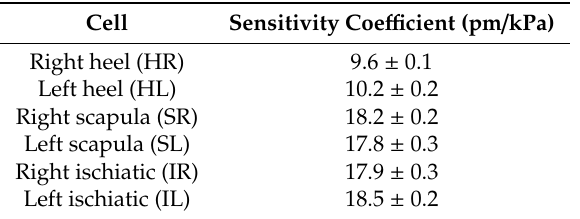
Table 1. Sensitivity coefficient of each cell to the applied pressure.